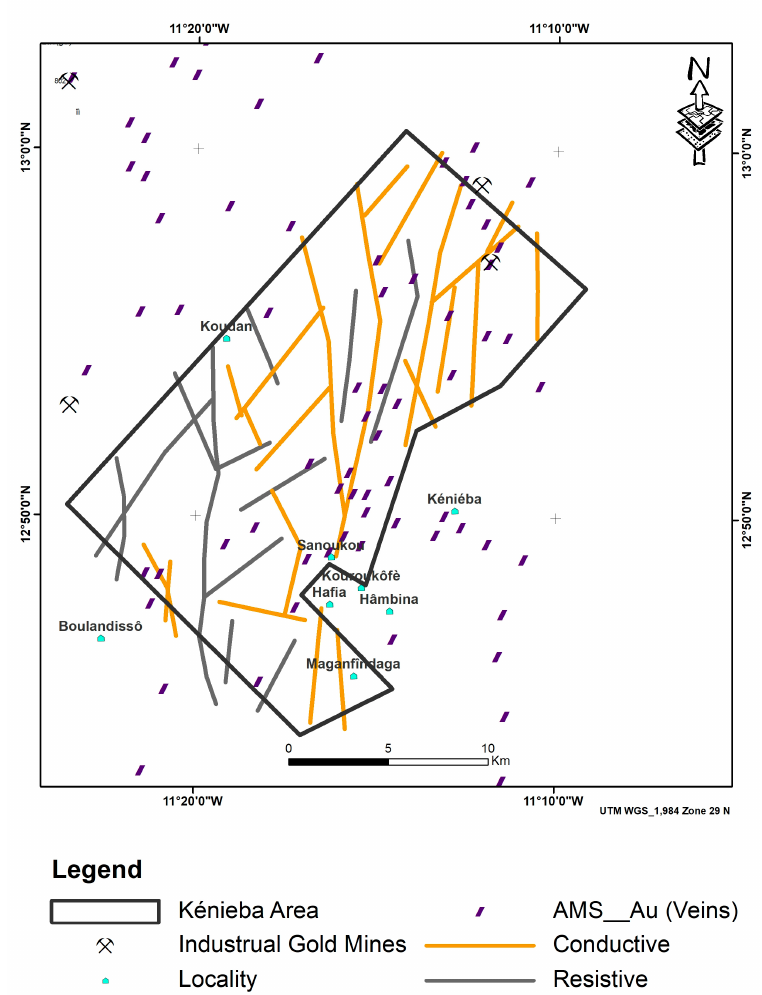
Figure 5. Overlapping of interpreted lineaments from three (3) orders of conductivity.